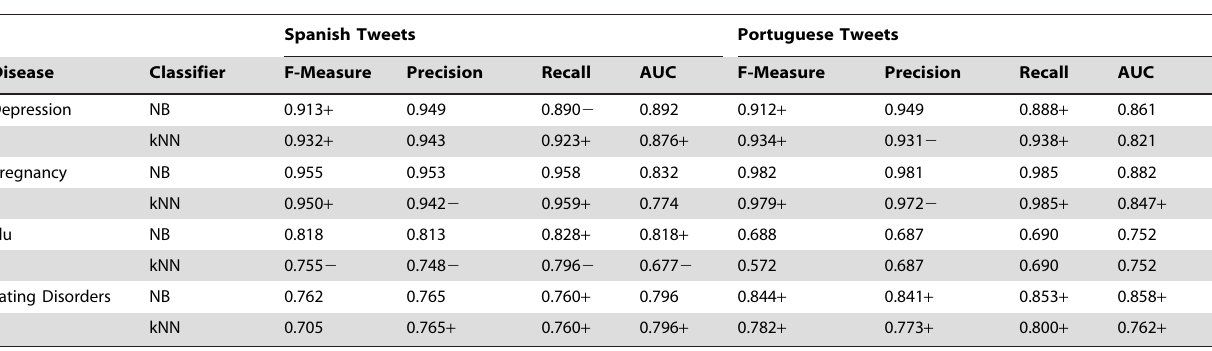
Table 7. Classification results obtained on subsets generated using CFS.